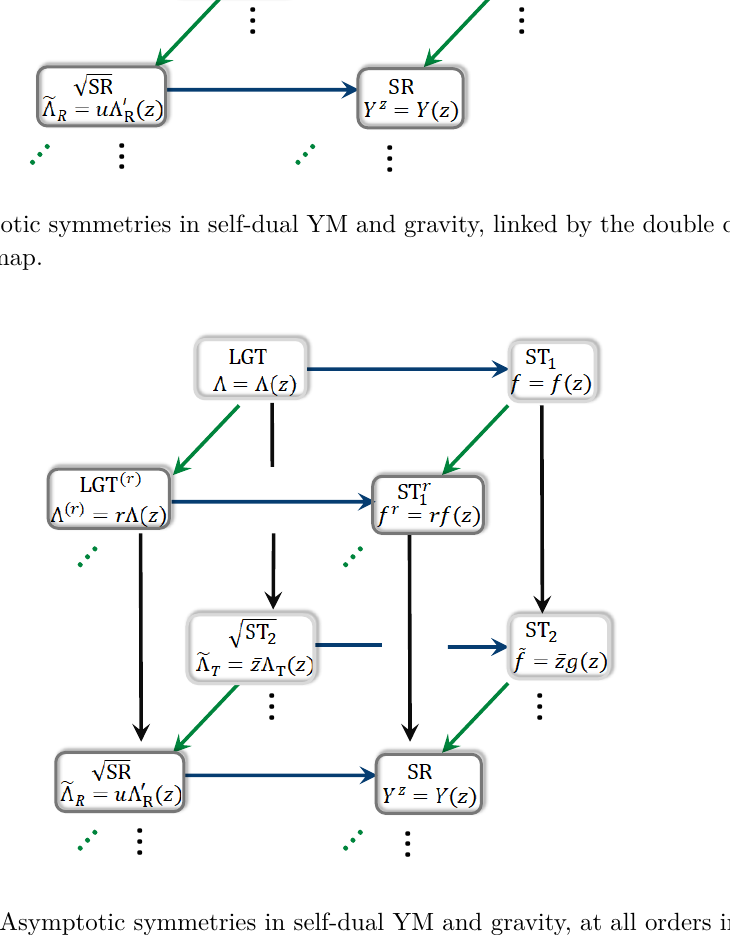
Figure 2 . Asymptotic symmetries in self-dual YM and gravity, at all orders in r . parameter u Λ 0 ( z ) was obtained by plugging a family 1 gauge symmetry with parameter r r Λ( z ) into the recursion relation (7.2) (see [24]). However, the transformation with